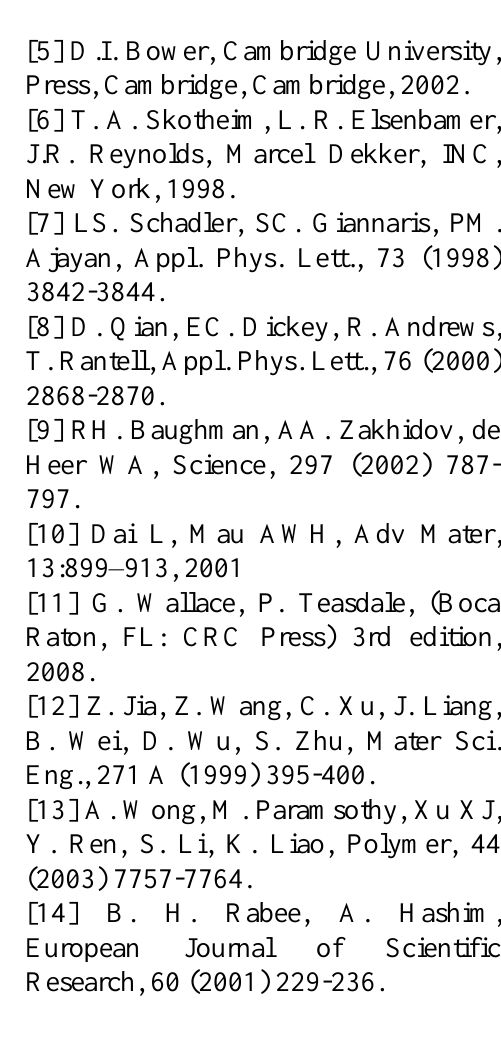
Fig.8: SEM image for PANI/MWCNTs nanocomposites thin films with MWCNTs wight concentration